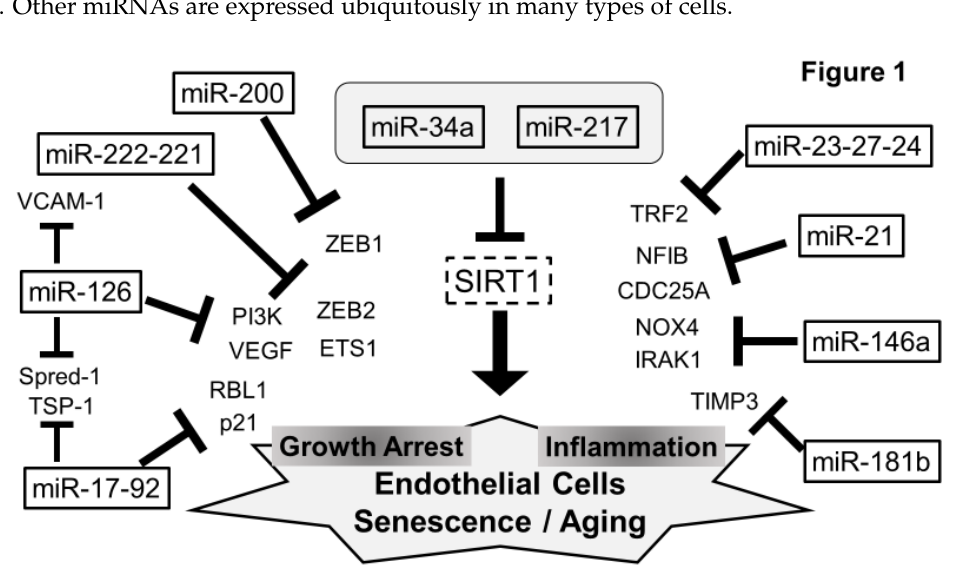
Figure 1. Schematic representation of endothelial miRNAs and their target in senescent ECs. The expression of miR ‐ 126, miR ‐ 17 ‐ 92, miR23 ‐ 27 ‐ 24, and miR ‐ 221 ‐ 222 are relatively abundant in ECs. In turn, miR ‐ 21, miR ‐ 181a, miR ‐ 146b, and miR ‐ 200 family, express ubiquitously in many types of cells, and influence the senescence of ECs. The increases of miR ‐ 34a and miR ‐ 217 suppress SIRT1 expression, leading to ECs aging.